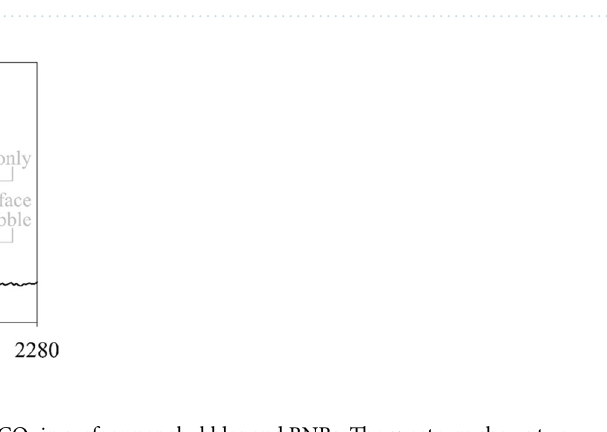
Figure 1. CO 2 BNBs generated in water. (a) Case 1 (low BNB concentration): 3.47 ± 0.39 × 10 8 NBs/mL, (b) case 2 (high BNB concentration): 4.94 ± 0.24 × 10 8 NBs/mL. The figures on the left are images of BNBs. The black background and white dots represent the water and BNBs, respectively. The figures on the right side are the size distributions of the BNBs immediately after generation in water.